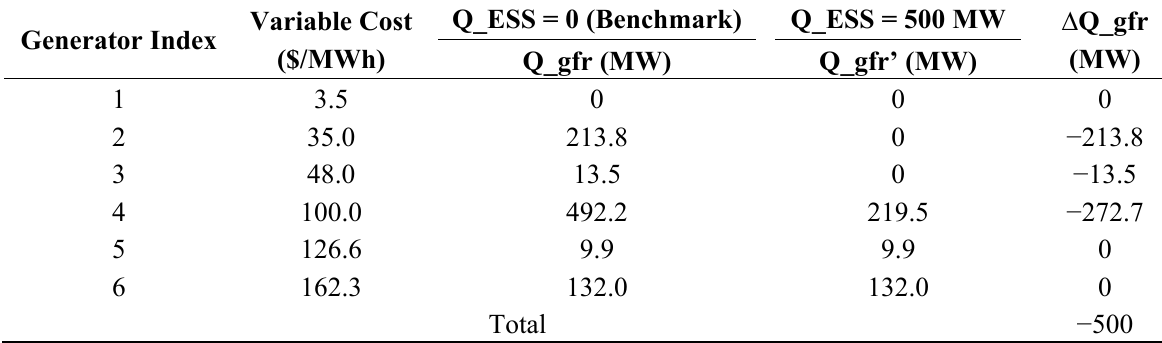
Table 1. Example of calculating Q_coff and Q_coff